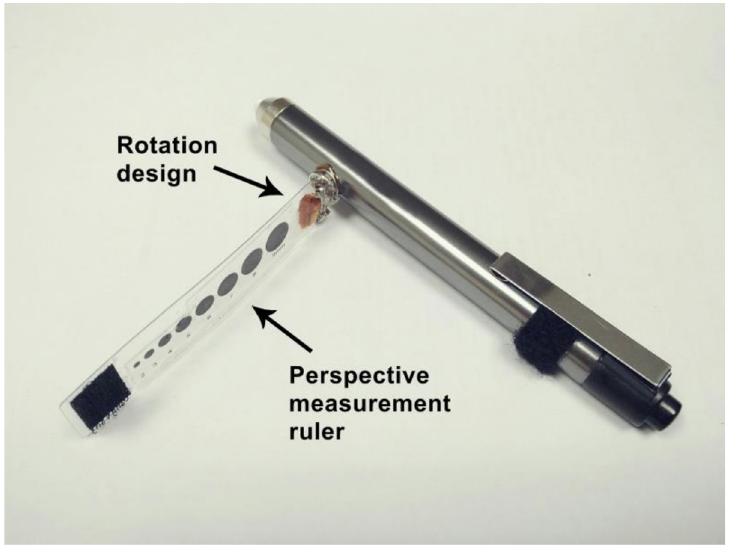
Fig 2. 3D printing of